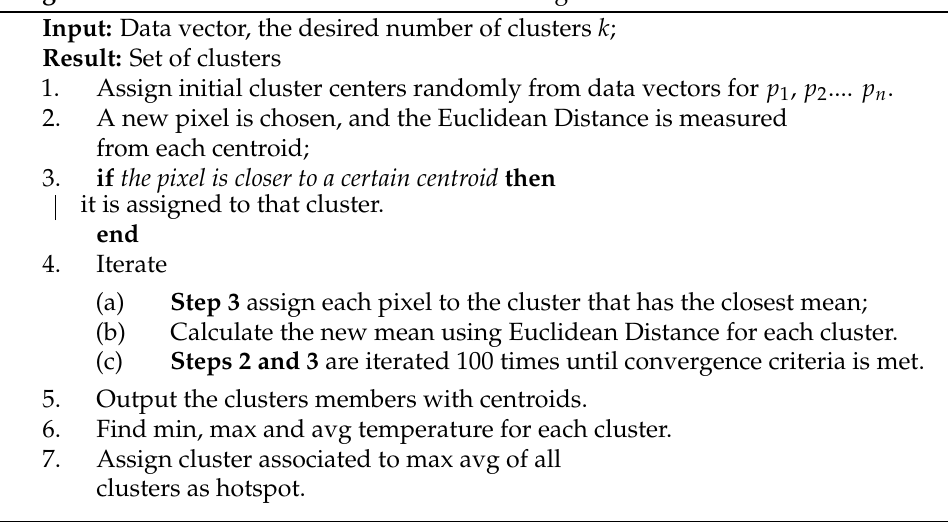
Algorithm 1: Pseudo code for K-means